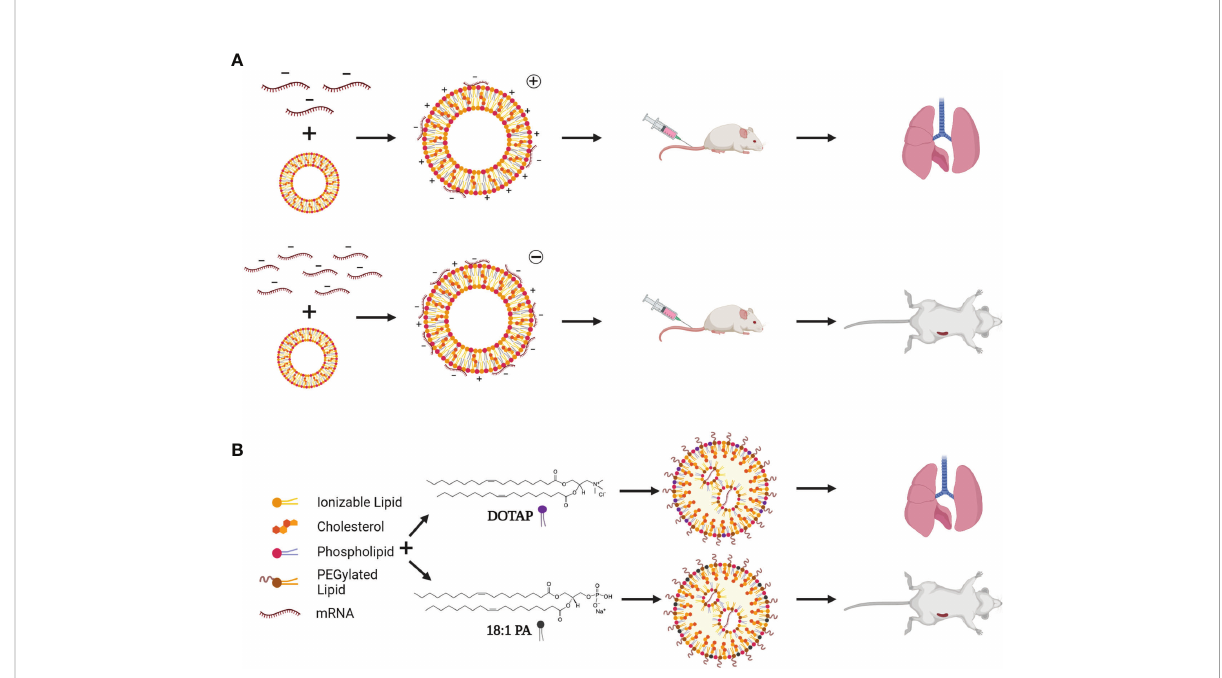
FIGURE 4 LNP targeting by charge switching and lipid choice. (A) By adding less mRNA (top), cLNPs are more positively charged, and target the liver after systemic injection. Addition of more mRNA to the exterior of cLNPs (bottom) changes the overall charge to negative, resulting in spleen targeting of cLNPs after systemic injection. (B) SORT (Selective Organ Targeting)-LNPs involve incorporating other targeting lipids such as DOTAP (1,2-dioleoyl-3-trimethylammonium-propane) and 18:1 PA (1,2-dioleoyl-sn-glycero-3-phosphate) to target speci fi c organs depending on the lipid used and percentage of the lipid included. A high percentage of DOTAP allows for lung targeting, while lower percentages would target the spleen. Addition of 18:1 PA results in spleen targeting after systemic injection. Created using